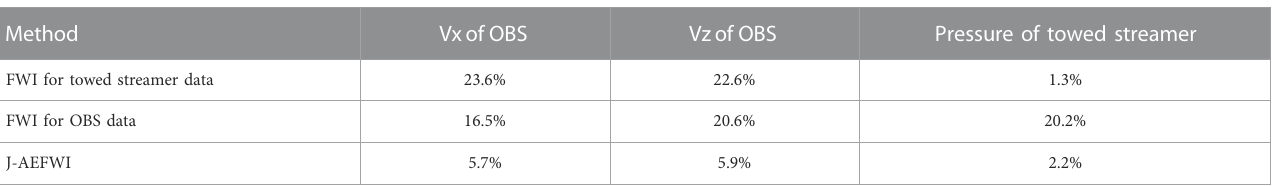
TABLE 1 The data residuals of the fi nal inversion